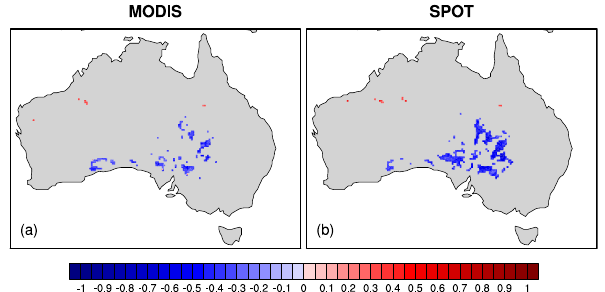
Figure 9. Zero-lag correlation between the differences in monthly mean soil moisture between CABLE and AMSR_E (CA- BLE − AMSR_E): (a) CABLE and MODIS black-sky NIR albedo (CABLE - MODIS) and (b) CABLE and SPOT black-sky NIR albedo (CABLE-SPOT). Correlations are computed at 95% signif- icance level over a monthly time series from 2003 to 2008, which corresponds to the availability of AMSR_E soil